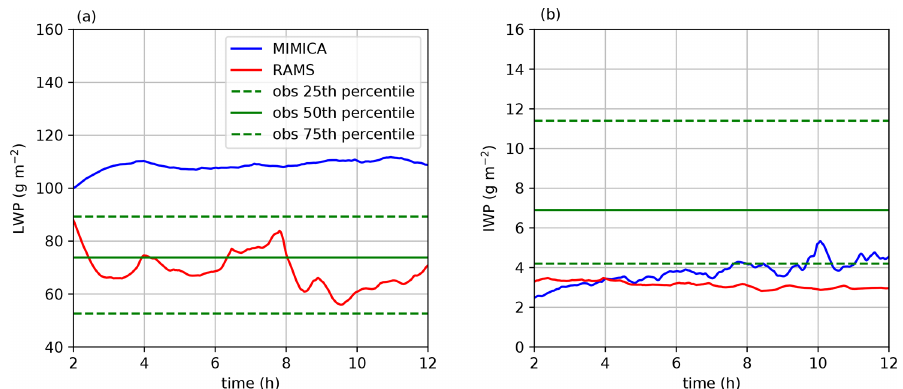
Figure 2. (a) LWP and (b) IWP simulated by MIMICA and RAMS for the baseline simulations, i.e. with accumulation and Aitken mode concentrations of 20cm − 3 . The retrieved values of LWP and IWP for the observed cloudy period defined in Sect. 2.2 and up to the height of the model domains are shown as 25th, 50th (median) and 75th percentiles. The first 2h of simulations, considered as the spin-up period, are excluded. The observed and simulated LWP and IWP include all liquid and ice water in the atmospheric column, i.e. water within and below the